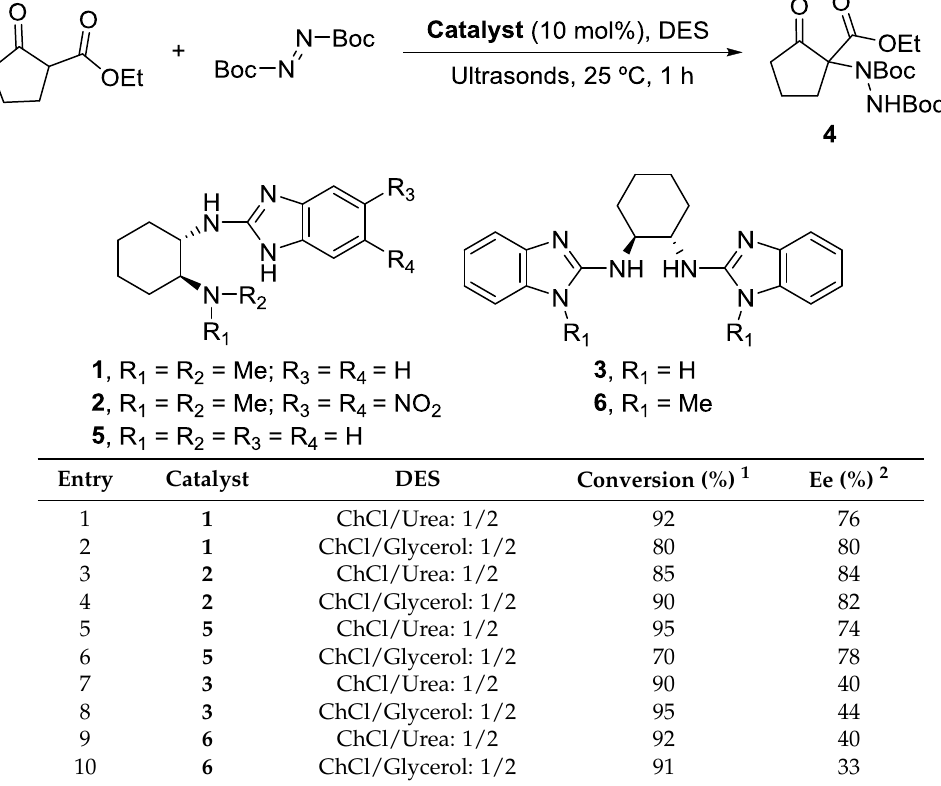
Table 2. Asymmetric α-amination of ethyl 2-oxocyclopentane-1-carboxylate with DBAB. Catalyst study.